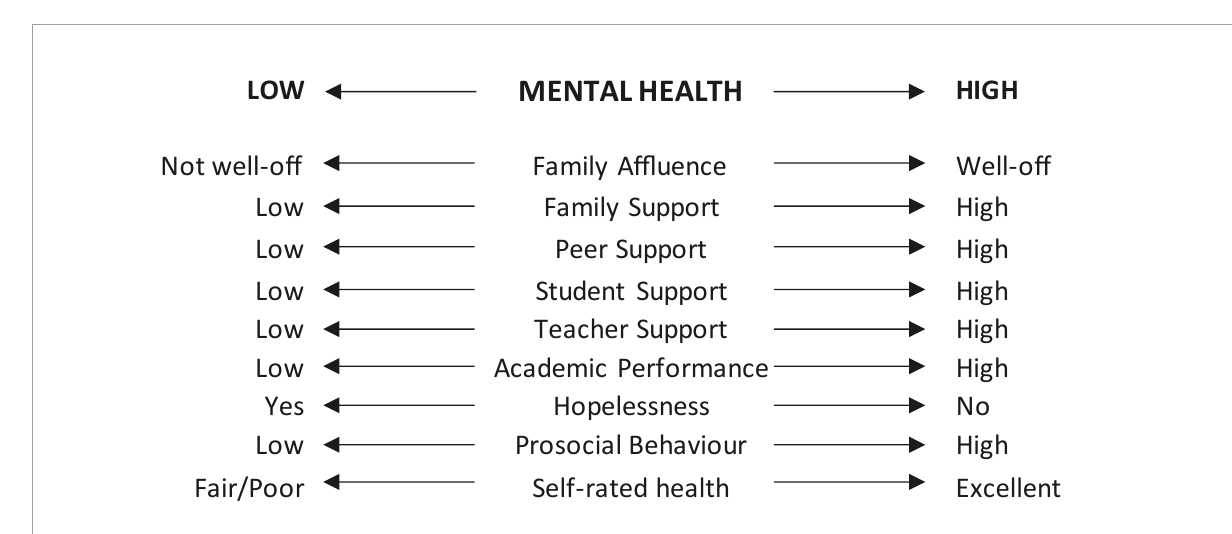
FIGURE3 Expected relationships between family affluence, social support, academic functioning, and indicators of mental health, and the composite mental health score.